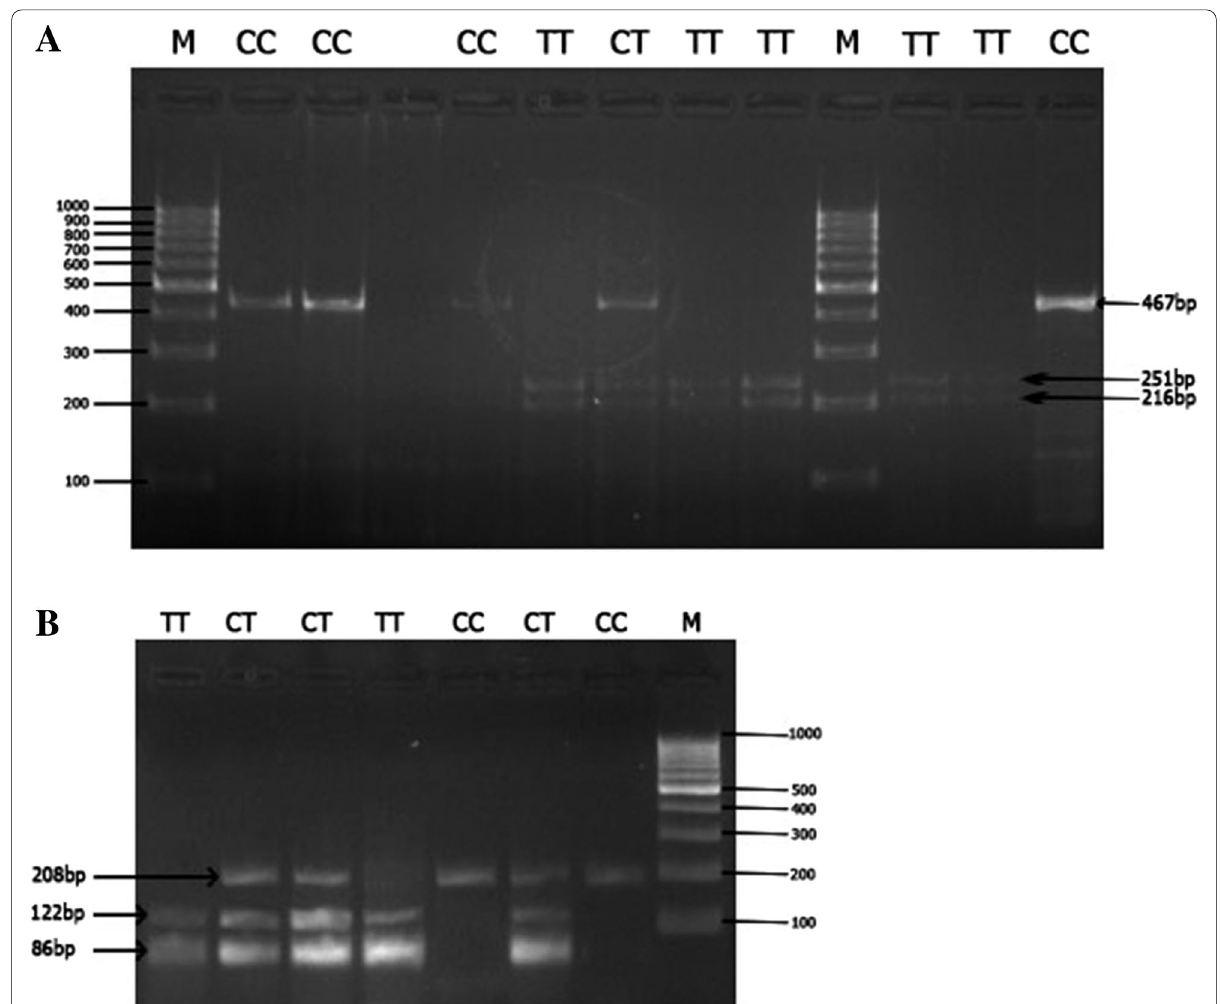
Fig. 1 Agarose gel electrophoresis showing RFLP analysis. A HIF-1α rs11549465 C>T. B VEGF rs3025039 C>T. M: Molecular weight